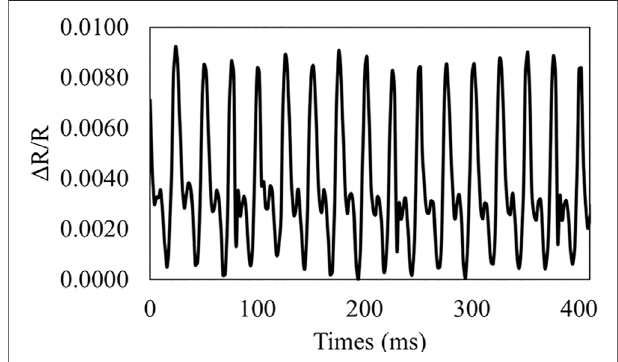
FIGURE 11 | Response of a PDMS-PEIE/MWCNTs-1 stretchable sensor to the vibration at 40 Hz.